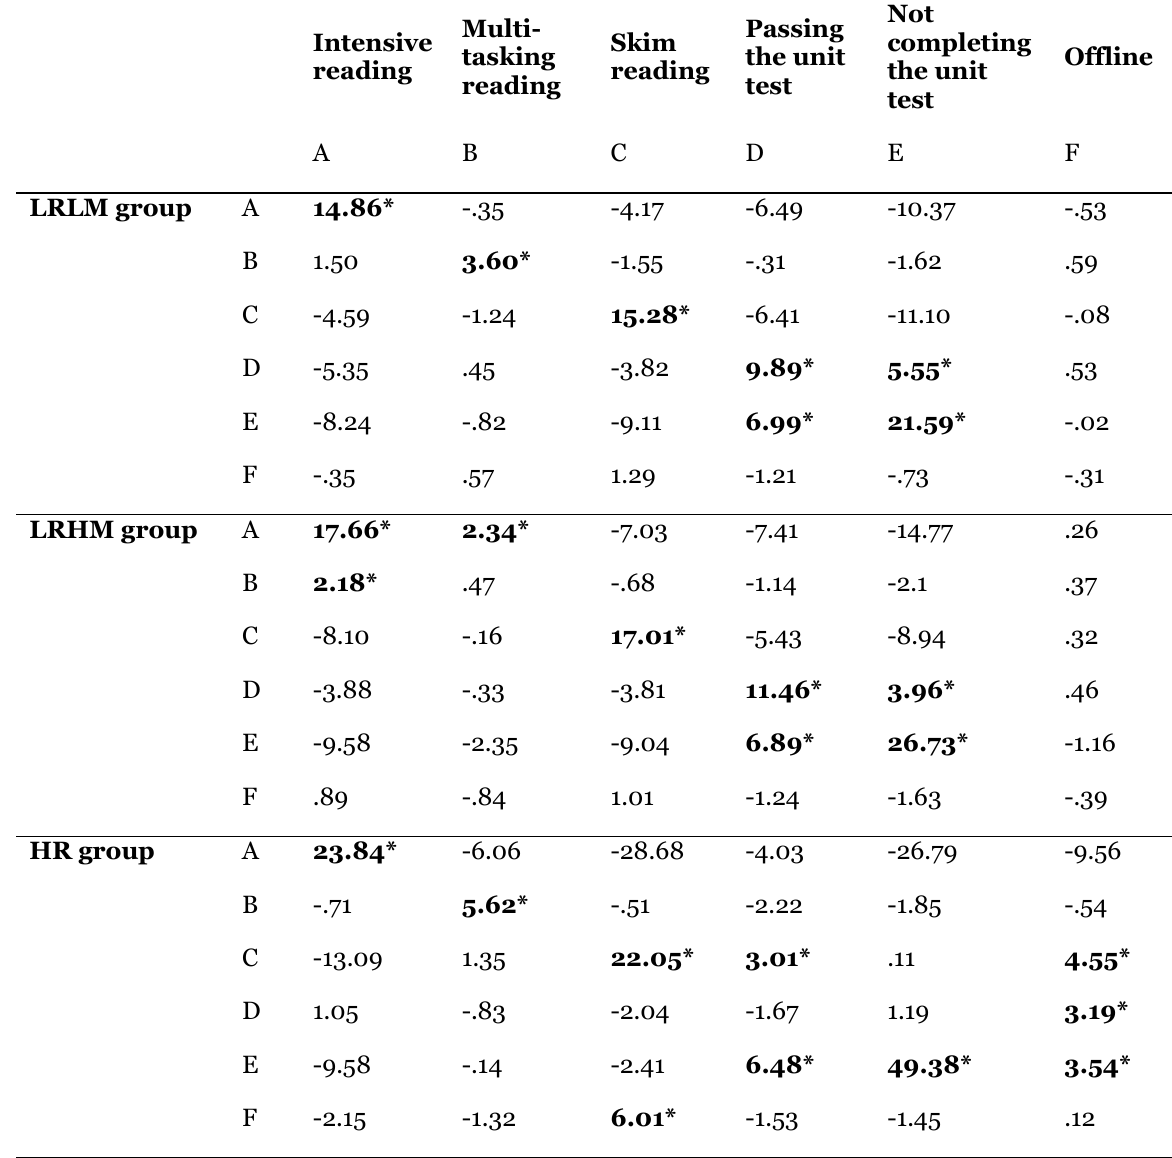
The Adjusted Residuals Table of the Three Student